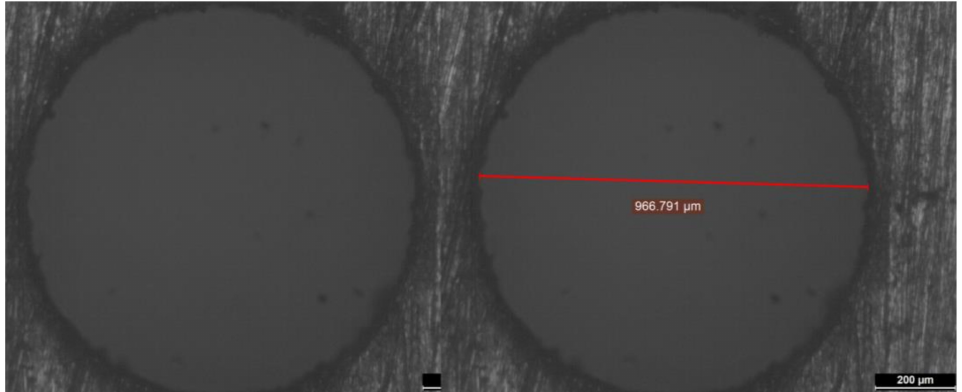
Figure 7. Optical images of microholes fabricated by micro spark-erosion drilling ( µ -SED) process using rotating brass hollow tool electrode of 800 µ m diameter.